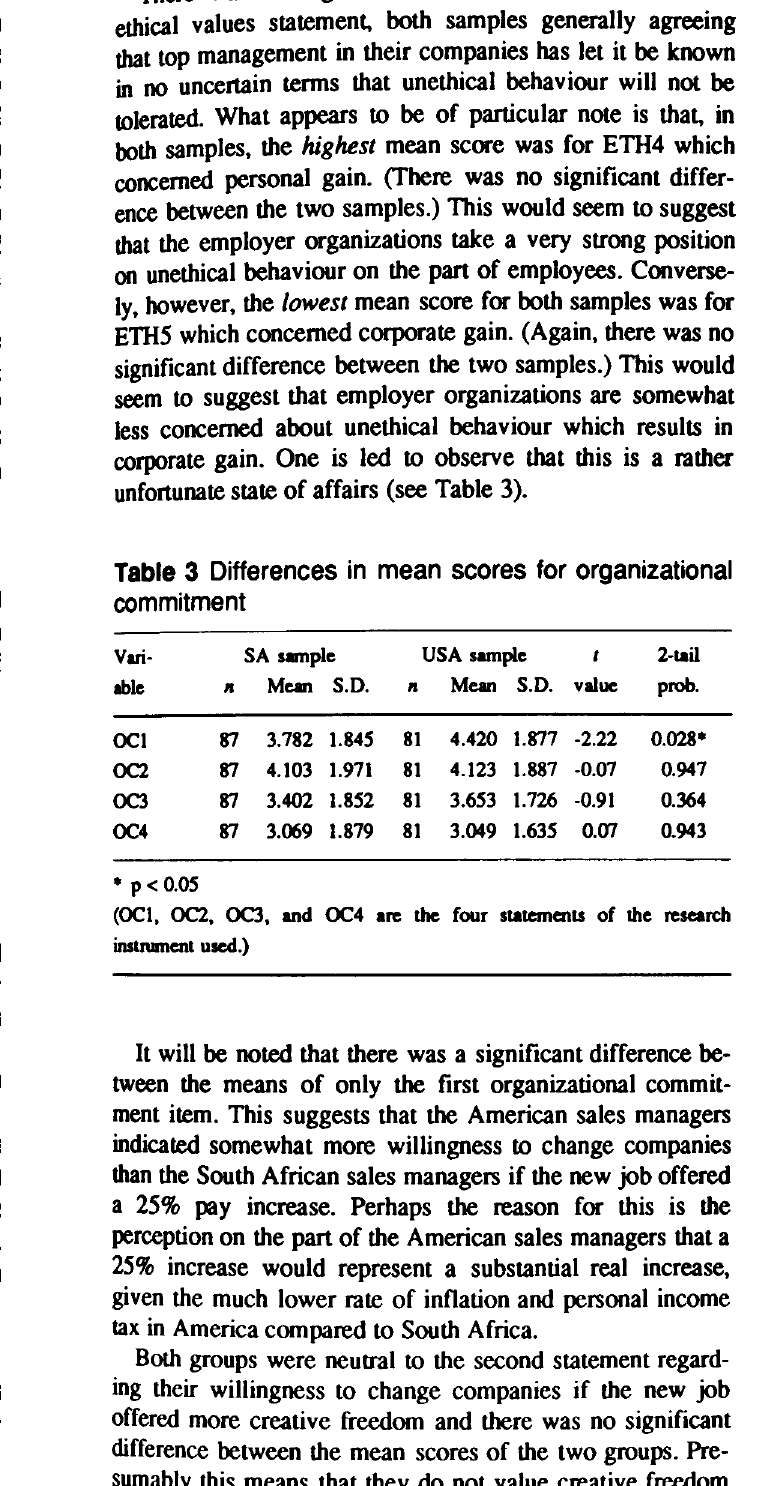
Table 4 Differences in mean scores for Machiavellian ism